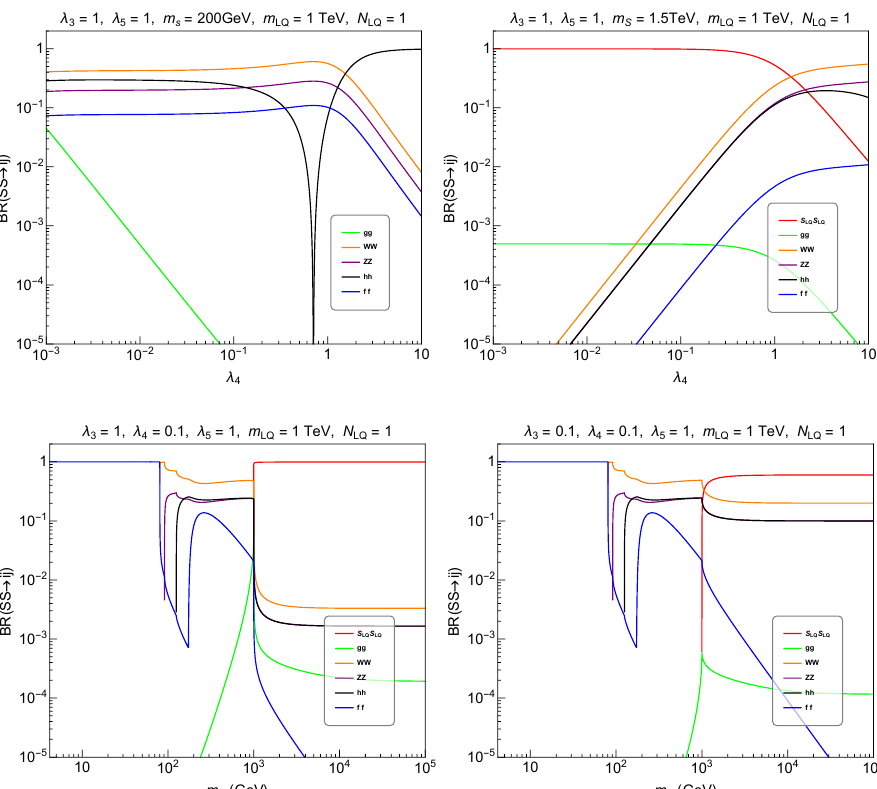
Figure 4 . Branching ratios of annihilation cross sections for dark matter as a function of (cid:21) 4 (upper panel) or m S (lower panel), in models with singlet scalar leptoquark. Branching ratios for WW (orange), ZZ (purple), gg (green), hh (black), f (cid:22) f (blue), and S LQ S (cid:3)